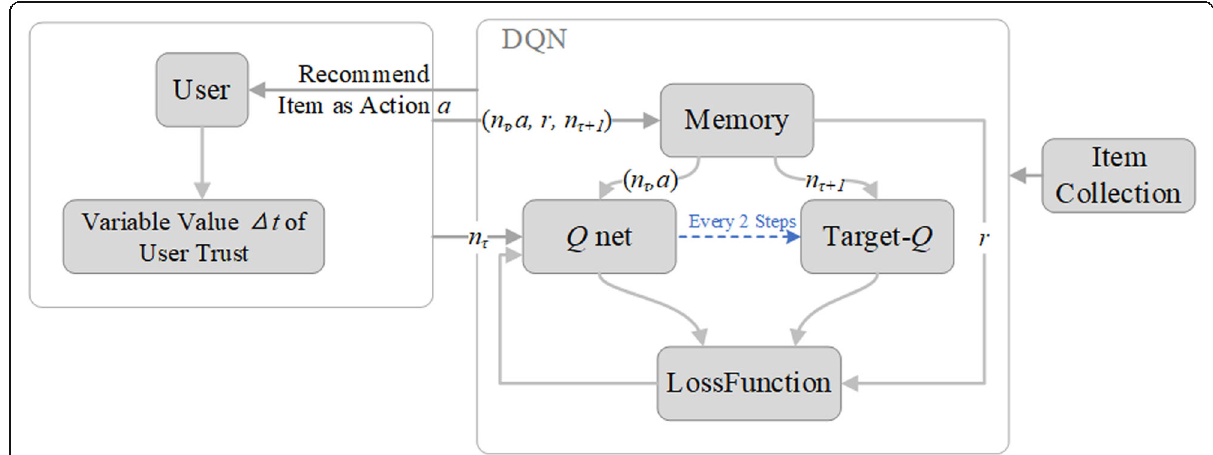
Fig. 4 Data transmission process of